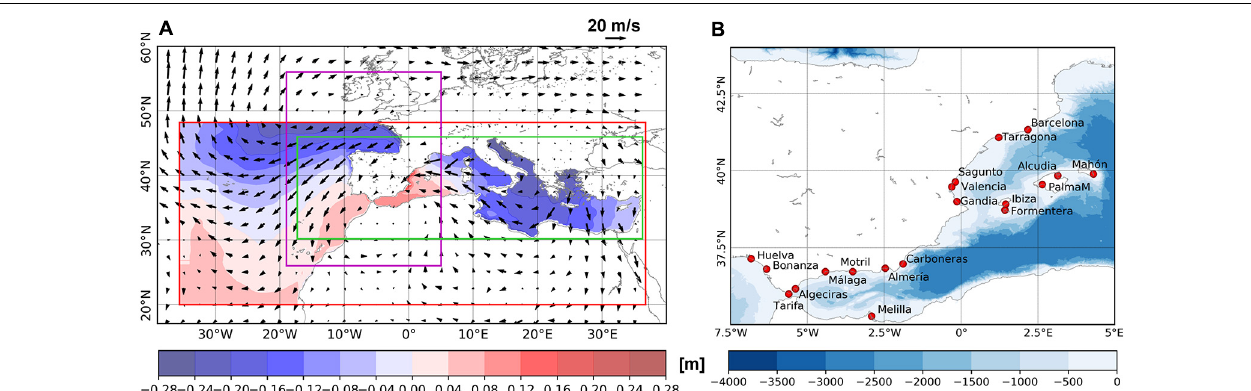
FIGURE 1 | (A) Daily averaged surge forecast from the Nivmar system during the Gloria storm-peak (2020/01/21). The colored areas show the positive (red scale) and negative (blue scale) surges. Units in meters. The black vector field represents the daily averaged wind fields from the ECMWF-IFS system. The rectangles show the domains of the three regional forecasts systems being used: in red, Nivmar; in green, MedFS and in magenta, IBI-MFS. (B) Red dots: List of the REDMAR tide gauges at the WM. The color bar shows the bathymetry elevation, in meters.